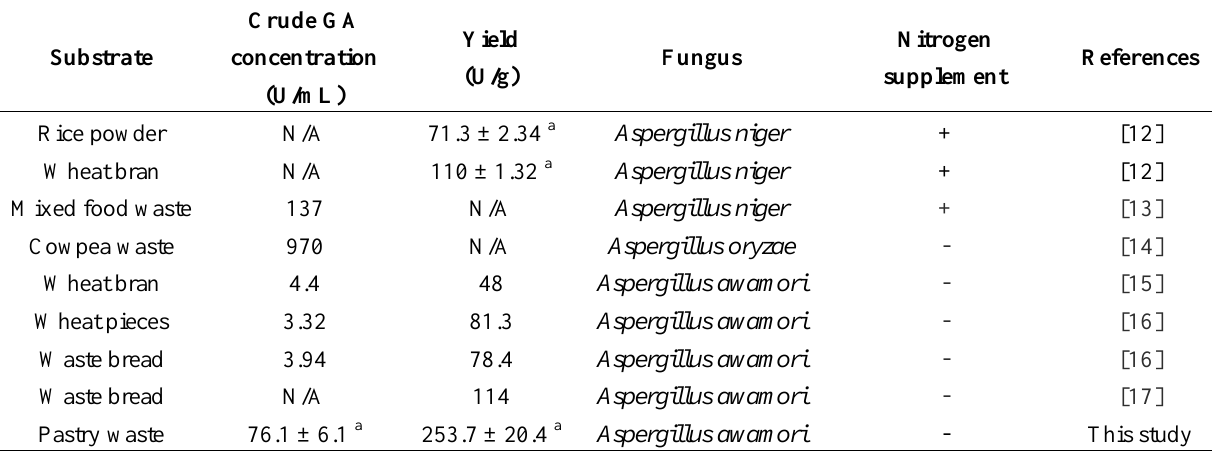
Table 1. GA production and yields from different studied substrates with or without nitrogen supplement through solid state